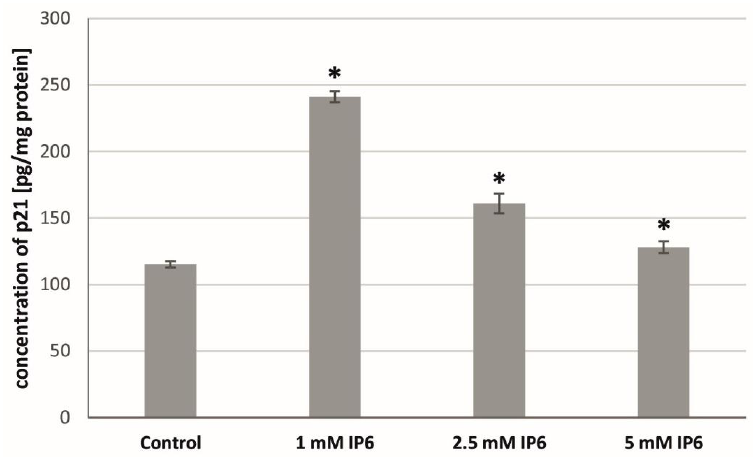
Figure 5. Effect of InsP6 at concentrations of 1 mM, 2.5 mM and 5 mM on the p21 Waf1/Cip1 concentration in Caco-2 cells at 24 h. The results are presented as mean ± SD of three separate experiments; * p < 0.05 vs. control.